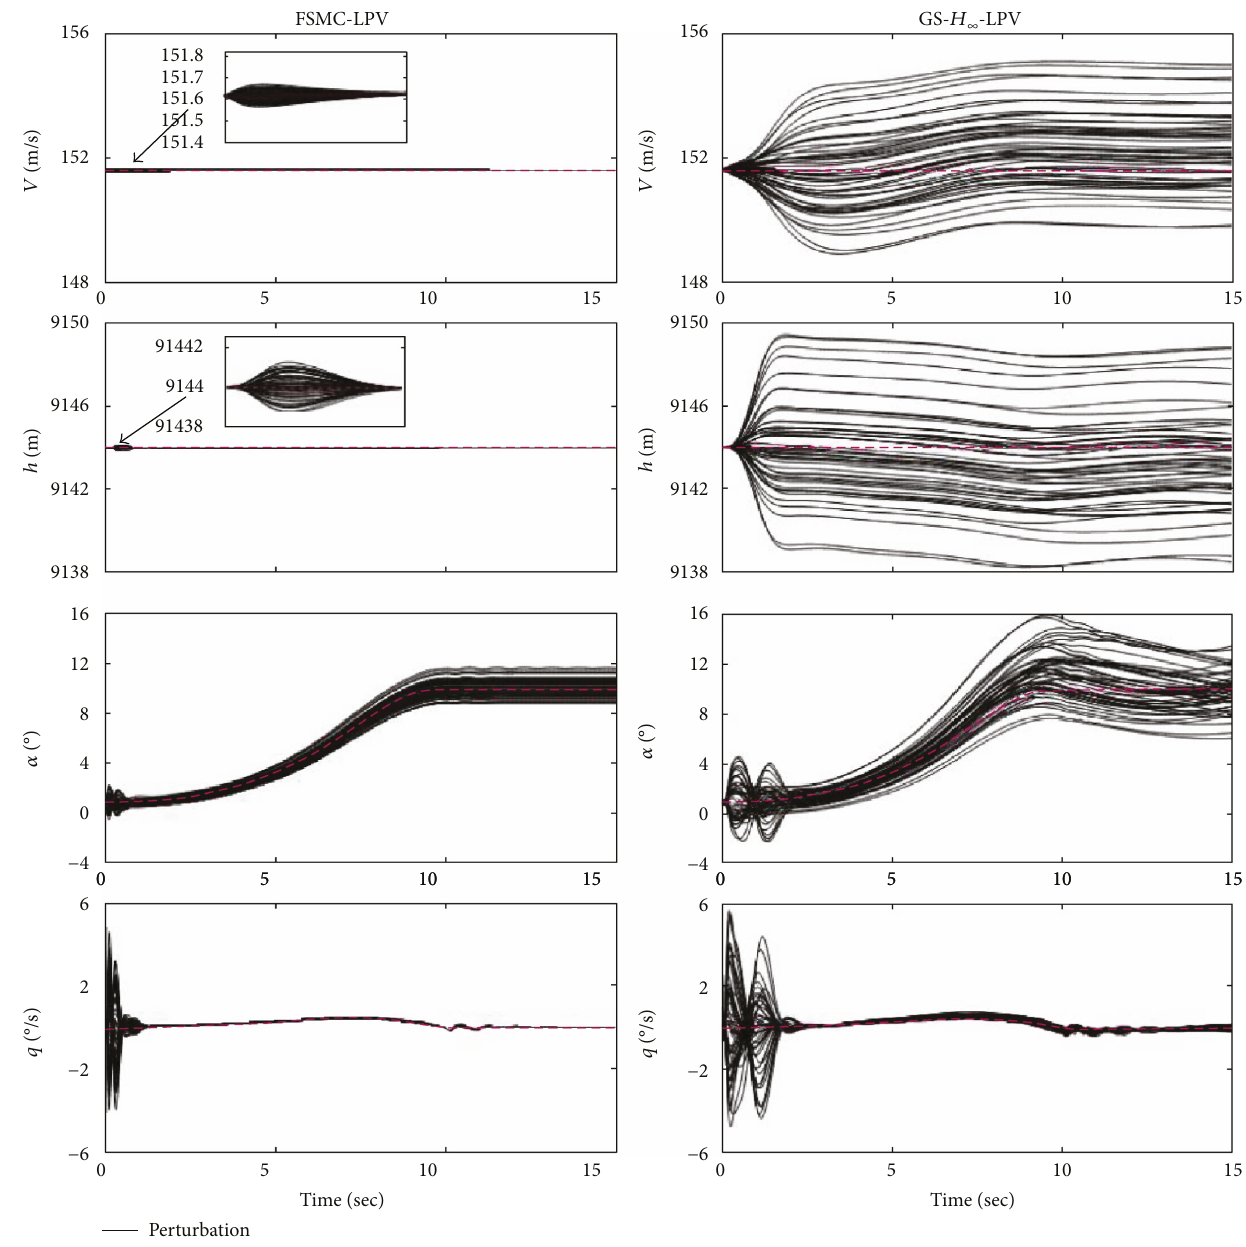
Figure 11: Closed-loop response during morphing